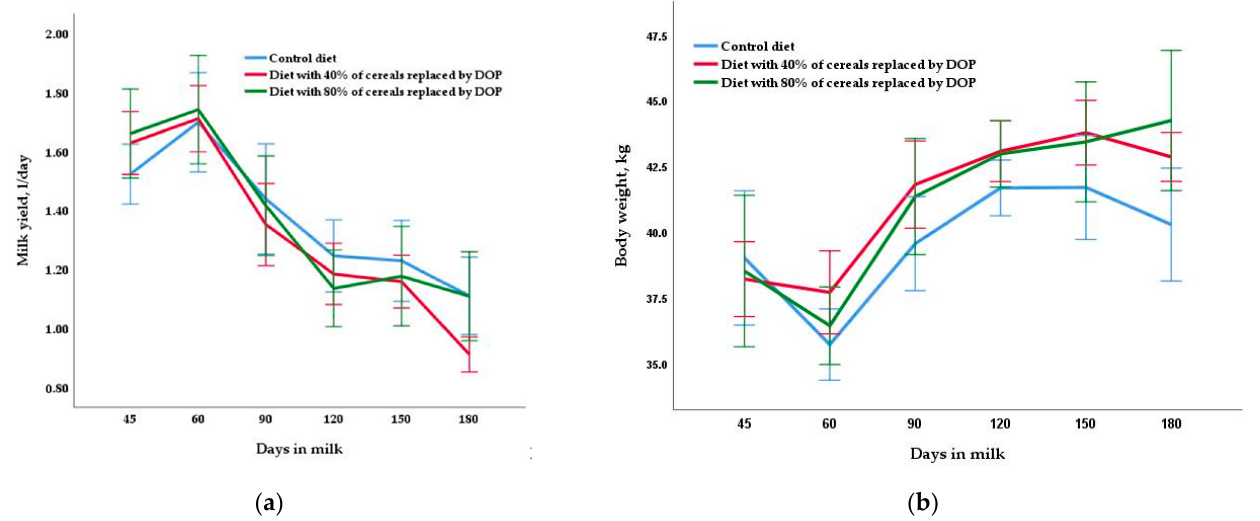
Figure 1. Changes throughout the lactation period (means ± SE) in milk yield ( a ) and body weight ( b ) due to dam diet treatments: control diet based on commercial concentrates plus alfalfa hay, diet based on concentrates with 40% of cereals replaced by dried orange pulp (DOP) plus alfalfa hay and diet based on concentrates with 80% of cereals replaced by DOP plus alfalfa hay. 3.2. Intake, Rumen Fermentation, Apparent Nutrient Digestibility, and Protein and Energy Balance.